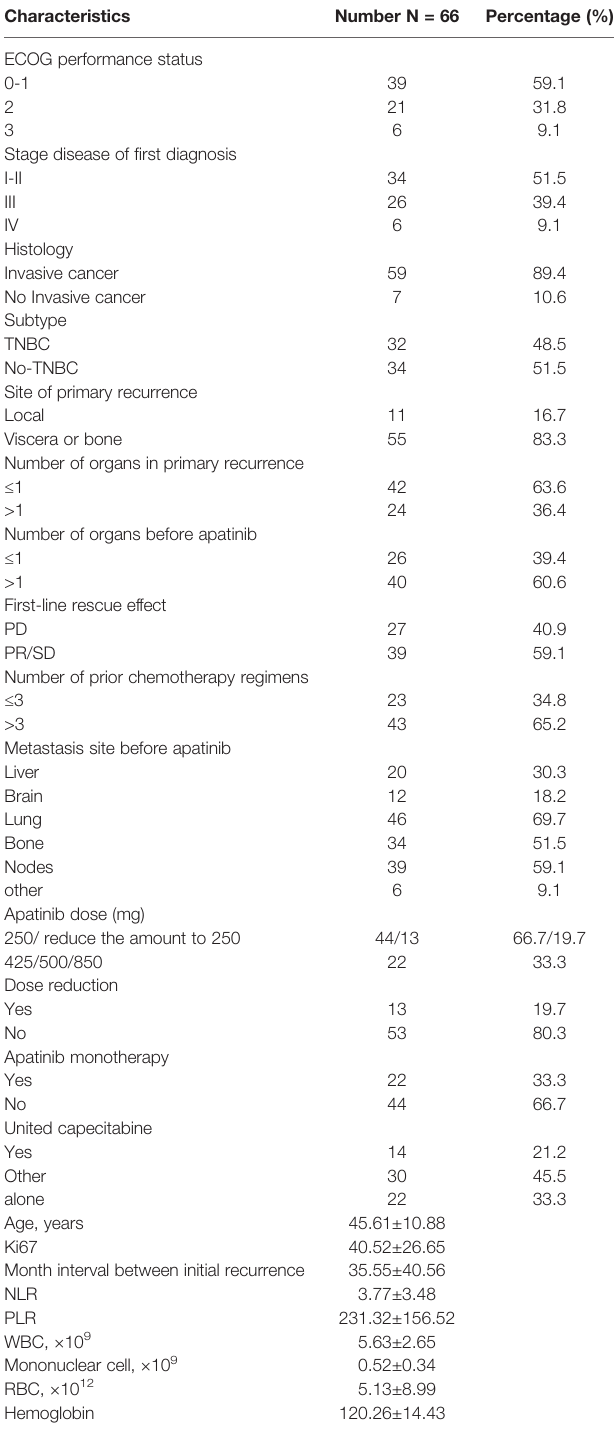
TABLE 1 | Patient characteristics. TABLE 2 | Treatment-Related